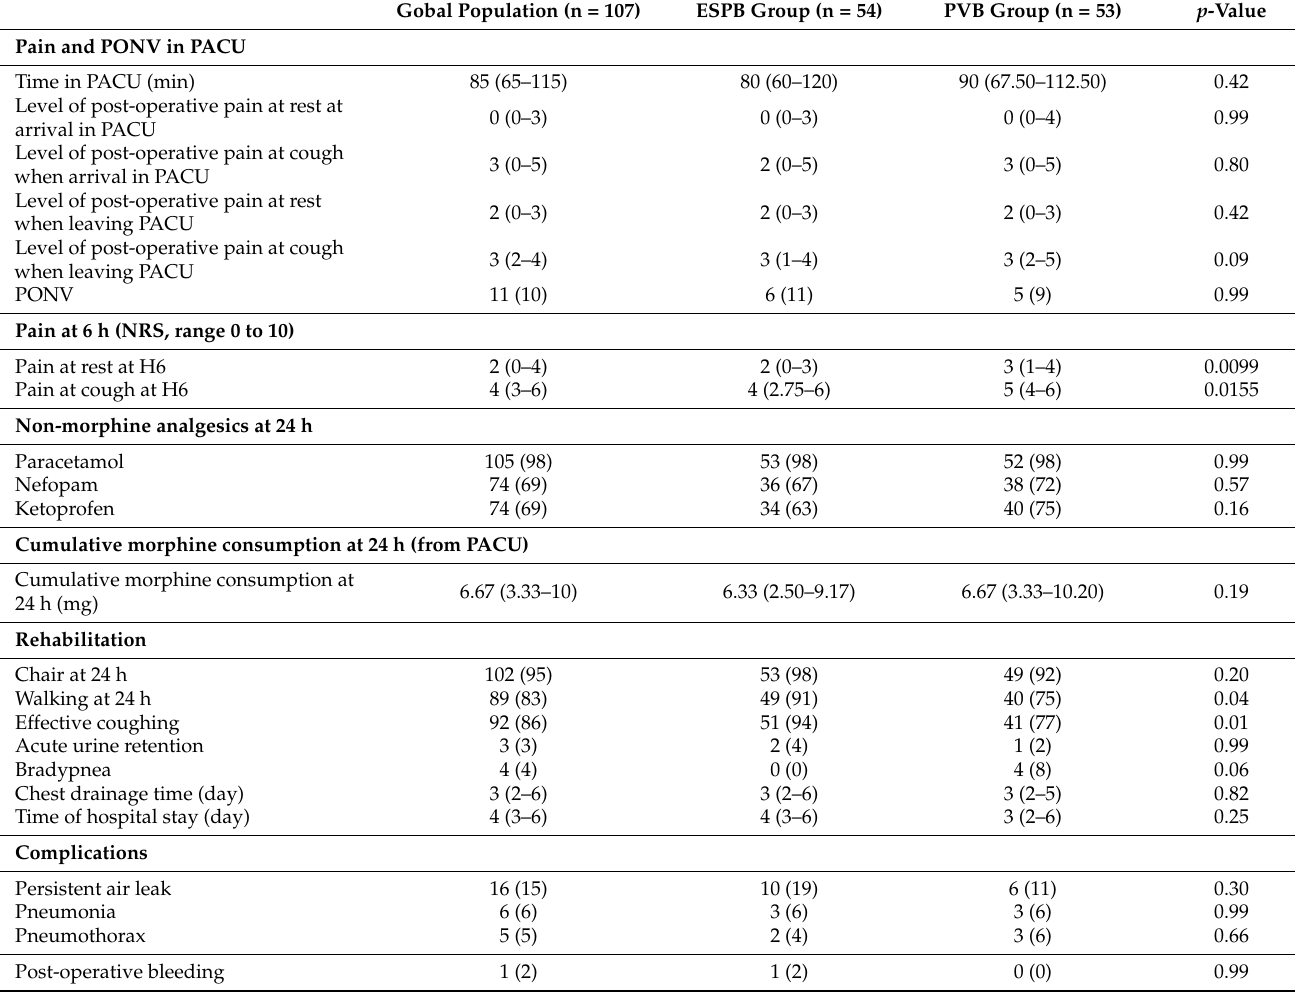
Table 3. Post-operative pain, morphine consumption and post-operative